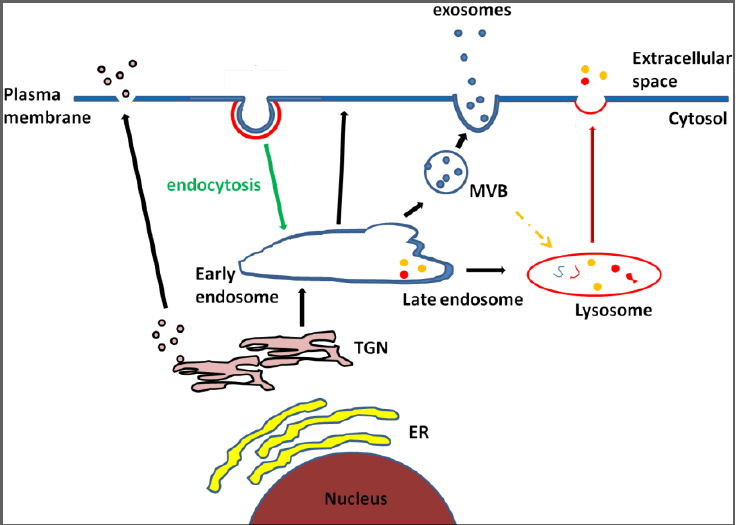
Figure 1. Schematic representation of exosome biogenesis. Extracellular molecules are endocytosed through various endocytic pathways such as clathrin mediated endocytosis or lipid rafts, and trafficked to early endosomes. The cargo and molecules are then recycled back to the plasma membrane; transferred to lysosome for degradation or secreted through exosome pathways. Evidence shows that the biogenesis of exosomes is mediated by intraluminal membrane budding at the Multi Vesicular Bodies (MVB) which are formed through an endosome maturation process. Both MVB and lysosome have been shown to be capable of fusing with the plasma membrane and releasing their contents, and some studies have highlighted the ability of MVB to fuse with the lysosome [1,73,74]. Classical soluble protein secretory pathways from Trans Golgi network (TGN) are also indicated. ER: endoplasmic